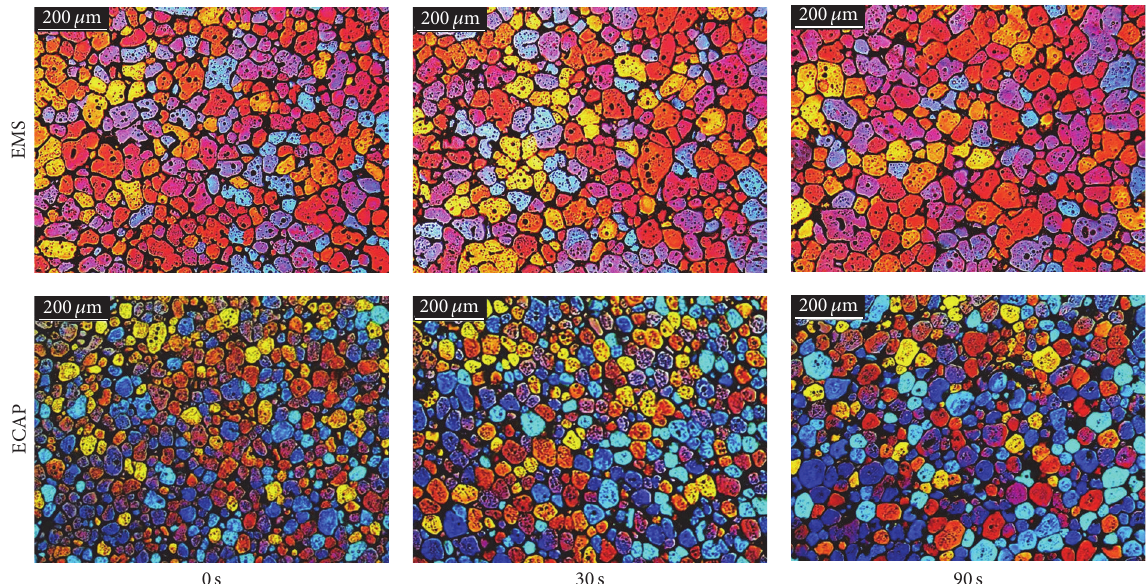
Figure 5: Polarized colour metallography of the EMS and ECAP samples heat treated at 584 ∘ C in which is expected to be 60% of solid fraction during 0, 30, and 90s holding time, showing the morphology of the